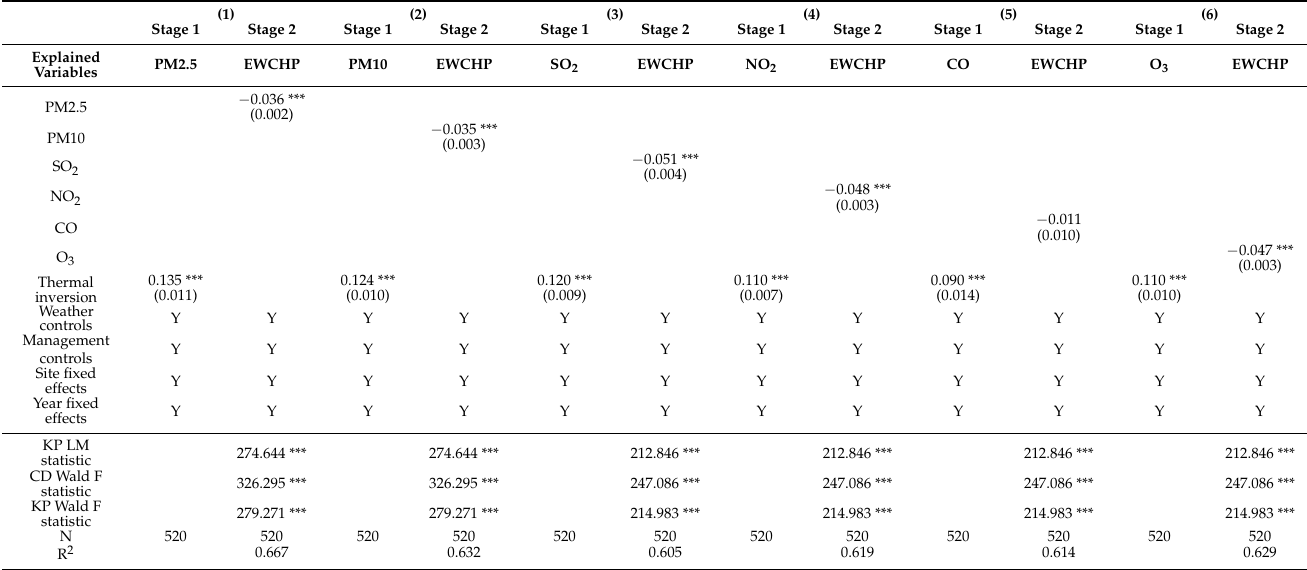
Table 3. IV estimation of the impact of air pollution on cultural heritage